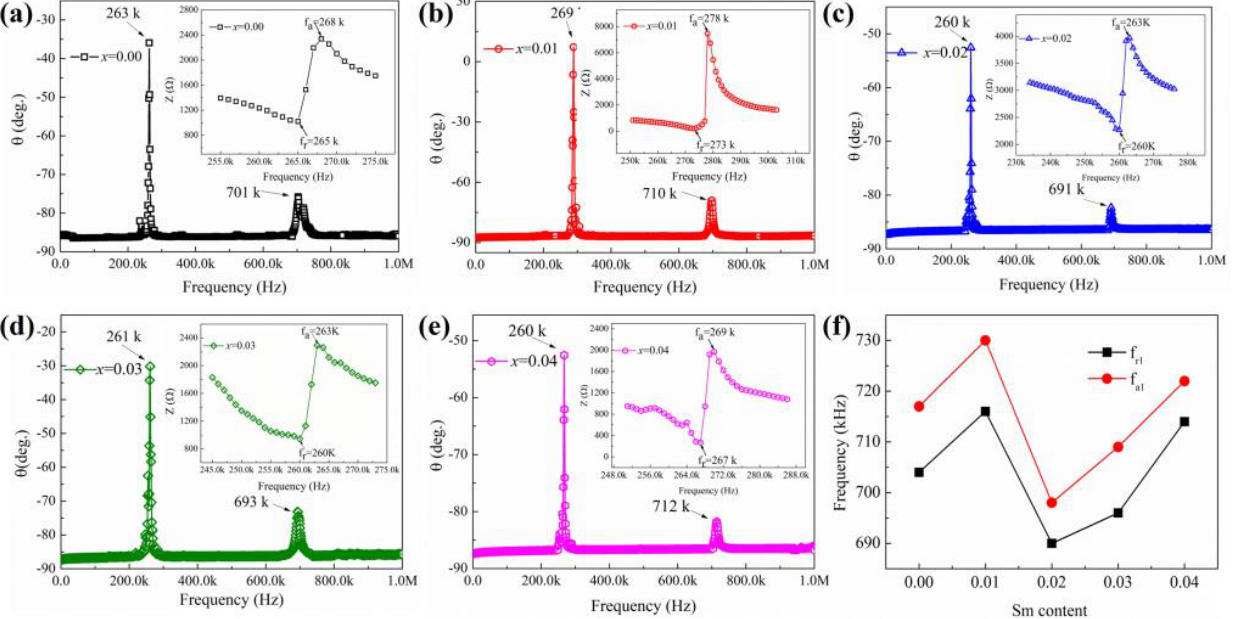
Figure 6. Impedance angle spectrum and impedance spectrum under fundamental frequency of porous BNBT6- x Sm ceramics at ( a ) x = 0, ( b ) x = 0.01, ( c ) x = 0.02, ( d ) x = 0.03, and ( e ) x = 0.04. ( f ) Resonant frequency ( f r1 ) and anti-resonant frequency ( f a1 ) under the first harmonic frequency of porous BNBT6- x Sm ceramics.